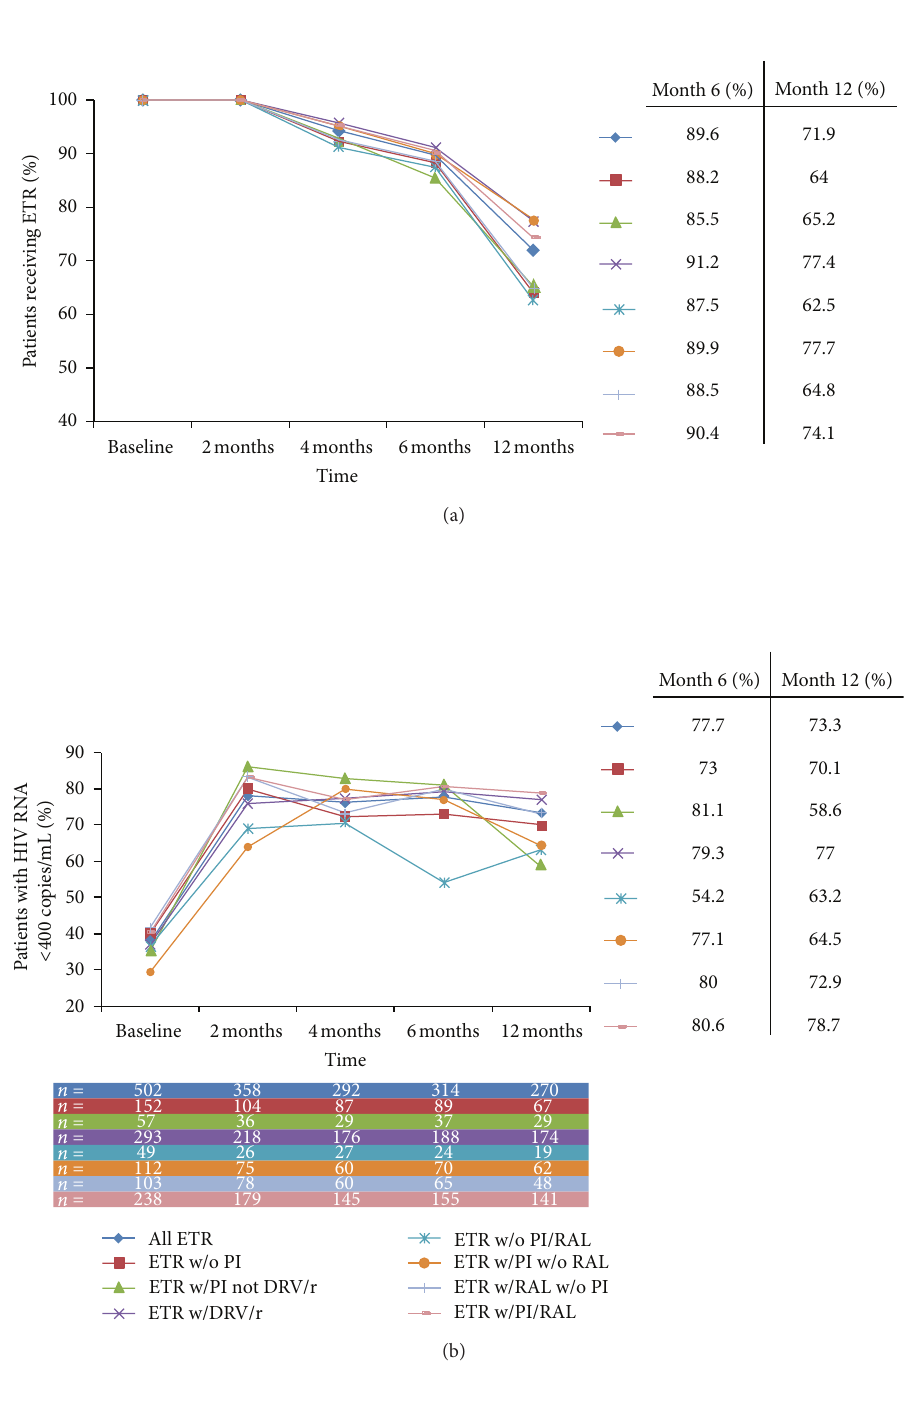
Figure 1: Proportion of patients (a) receiving etravirine over time, by regimen and (b) with HIV-1 RNA < 400 copies/mL over time (observed), by regimen. ETR: etravirine; w/o: without; PI: protease inhibitor; w/: with; DRV/r: darunavir/ritonavir; RAL: